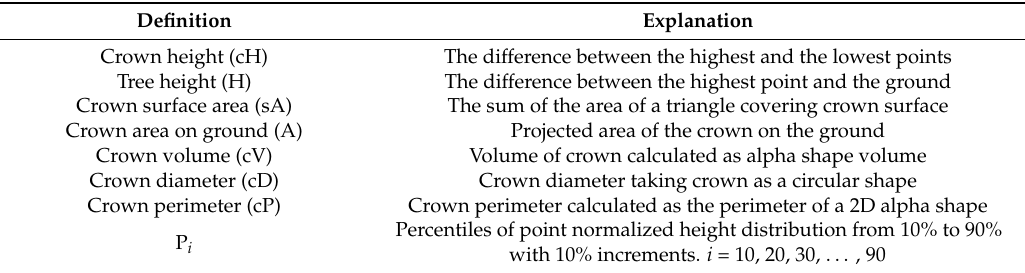
Table 3. Definition and explanation of derived crown